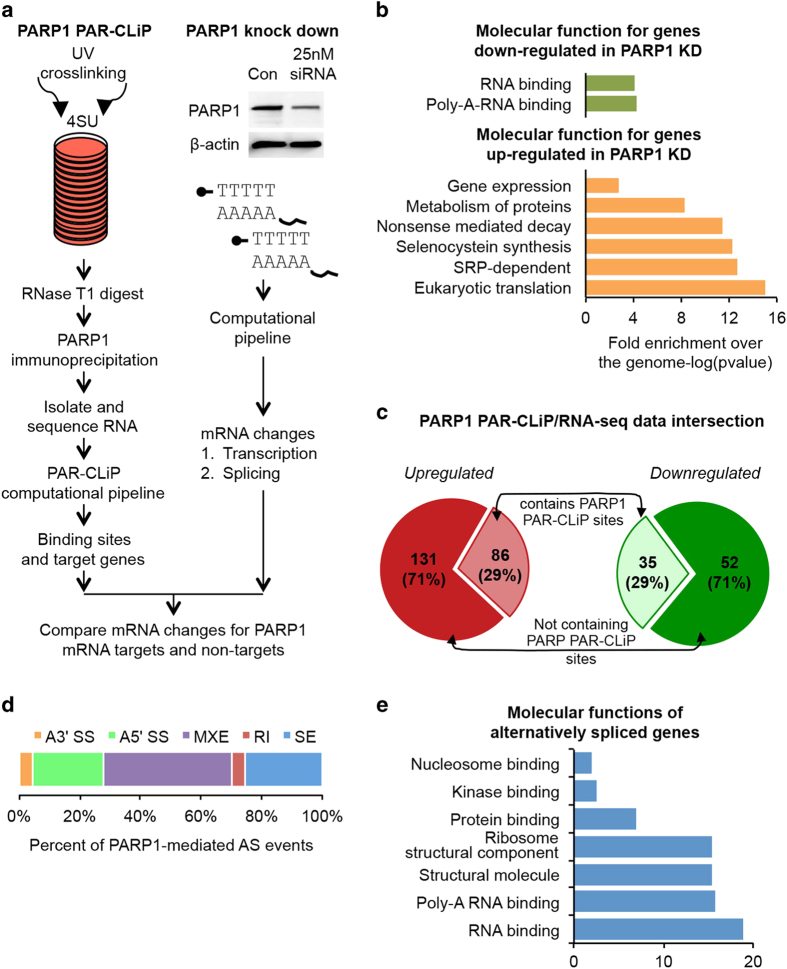
Loss of PARP1 targeted transcriptional and splicing regulation. (a) Experimental and computational workflow for analyzing the intersection of RNAs bound by PARP1 and RNAs whose expression is mediated by PARP1. Left side shows PAR-CLIP workflow, whereas the right side shows RNA-seq workflow after PARP1 depletion (b). Gene Ontology (Molecular function terms) for genes with significantly changed expression in PARP1 knockdown cells. (c) Proportion of genes overlapping in combined RNA-seq/PARP1-PAR-CLIP data sets. (d) Percentage of the alternative splicing events identified as PARP1 mediated with PARP1 knockdown: alternative 3′ splice site (orange); alternative 5′ splice site (green); mutually exclusive exons (purple); retained intron (pink); skipped exon (blue). (e) Gene Ontology analysis (molecular function terms) of the genes identified as PARP1-regulated at the splicing level.